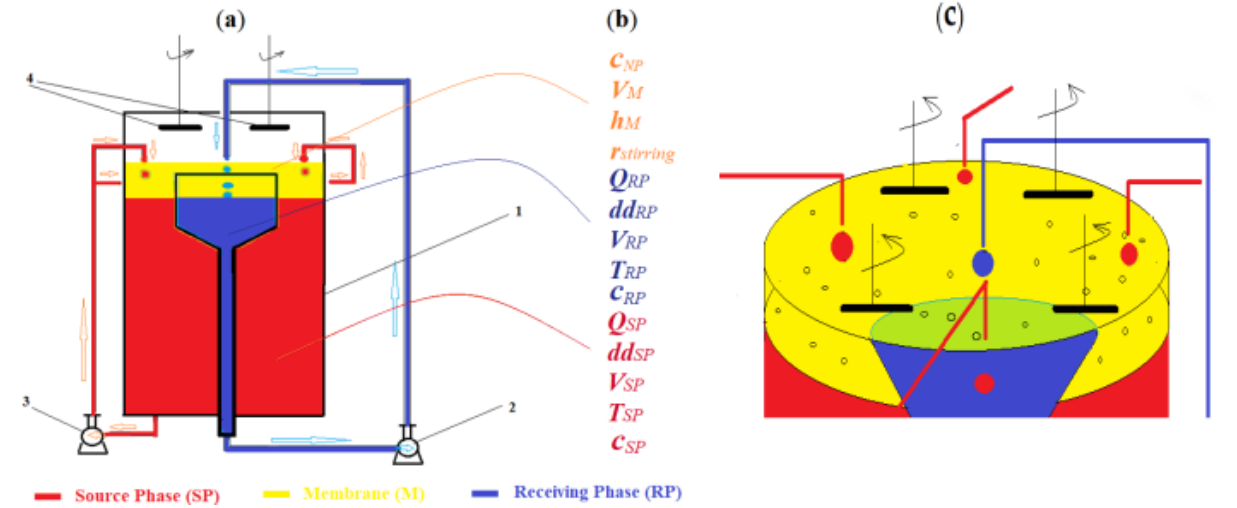
Figure 2. The dispersion bulk liquid membrane module: ( a ) functional scheme: 1—the module; 2 and 3—variable flow pumps; 4—magnetic rod stirrers; ( b ) variable parameters: C NP —nanoparticles’